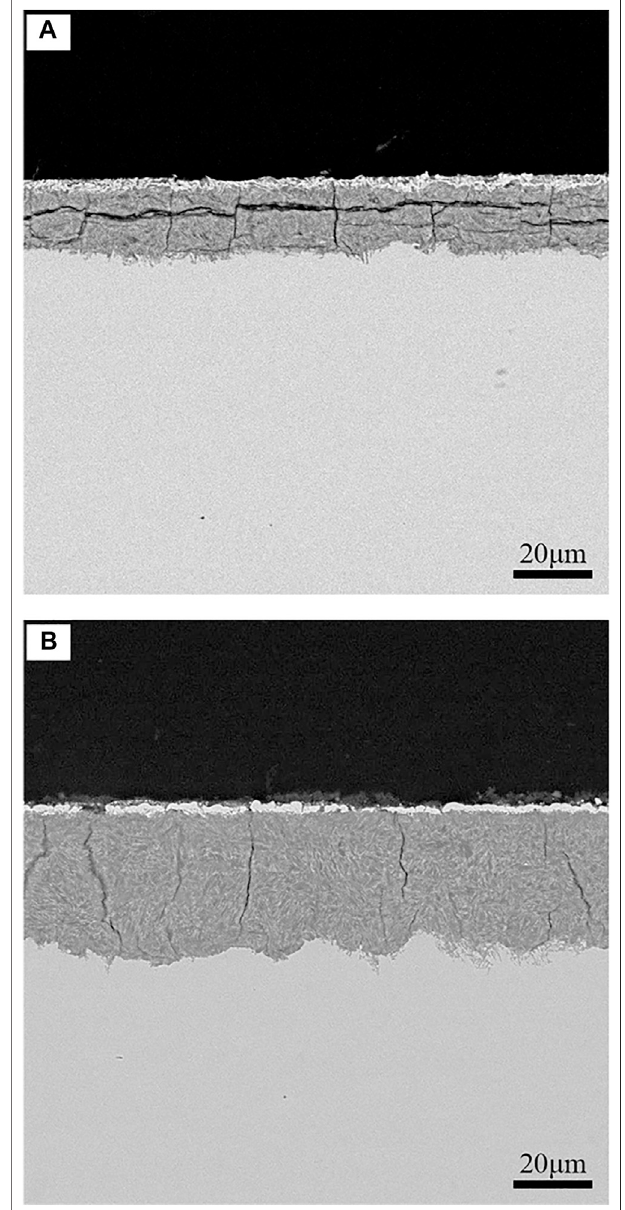
FIGURE 9 | Cross-sectional morphologies of HP-13Cr SS after LA immersion. (A) 95 ° C/2.8 MPa and (B) 120 ° C/3.2